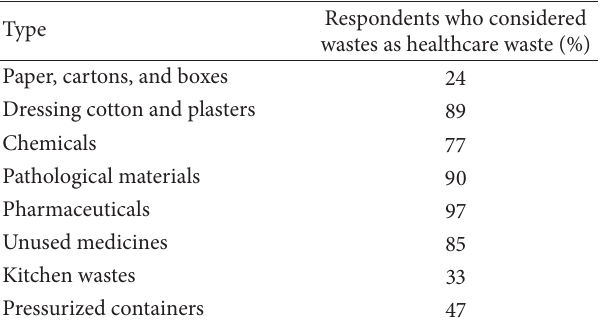
Table 3: Knowledge of employees of classification of